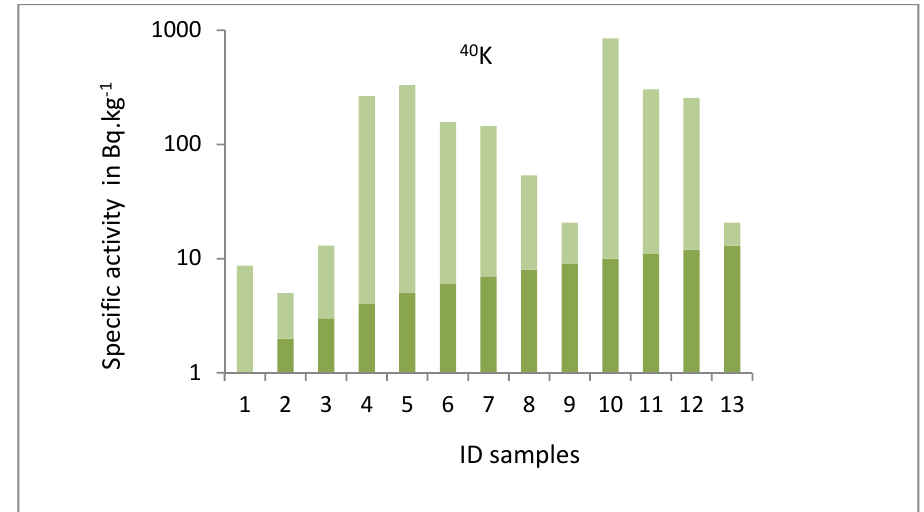
Fig.3: The specific activity of 40 K in the samples collected from a surface and above the RC.